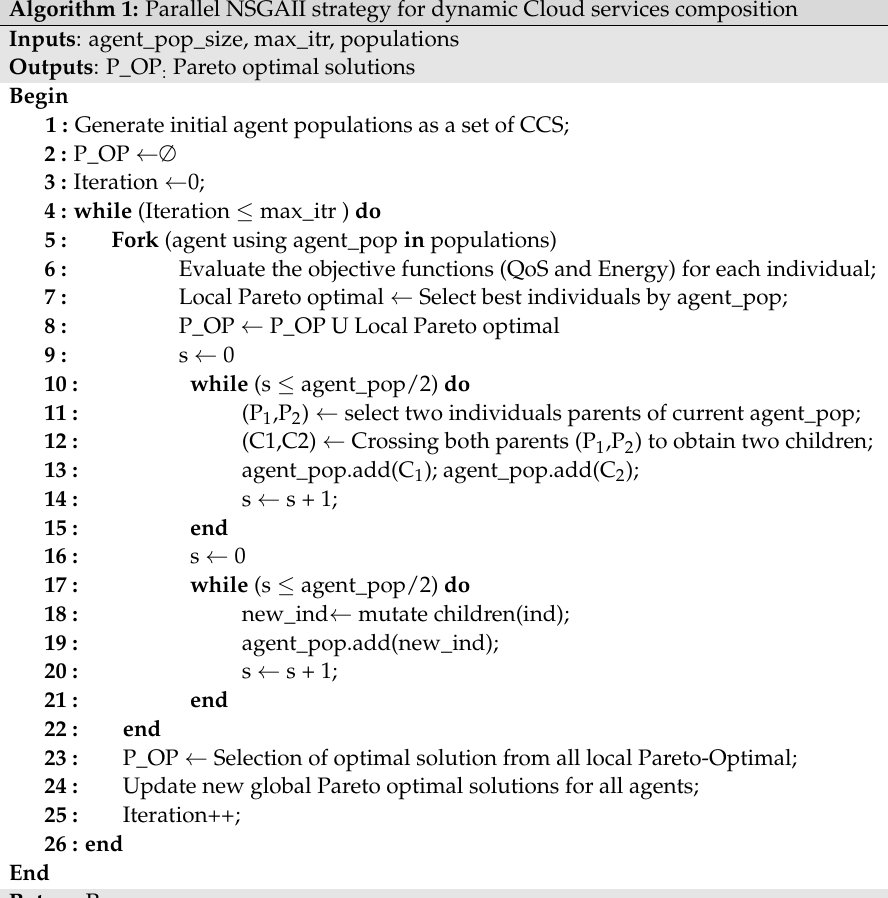
Algorithm 1: Parallel NSGAII strategy for dynamic Cloud services